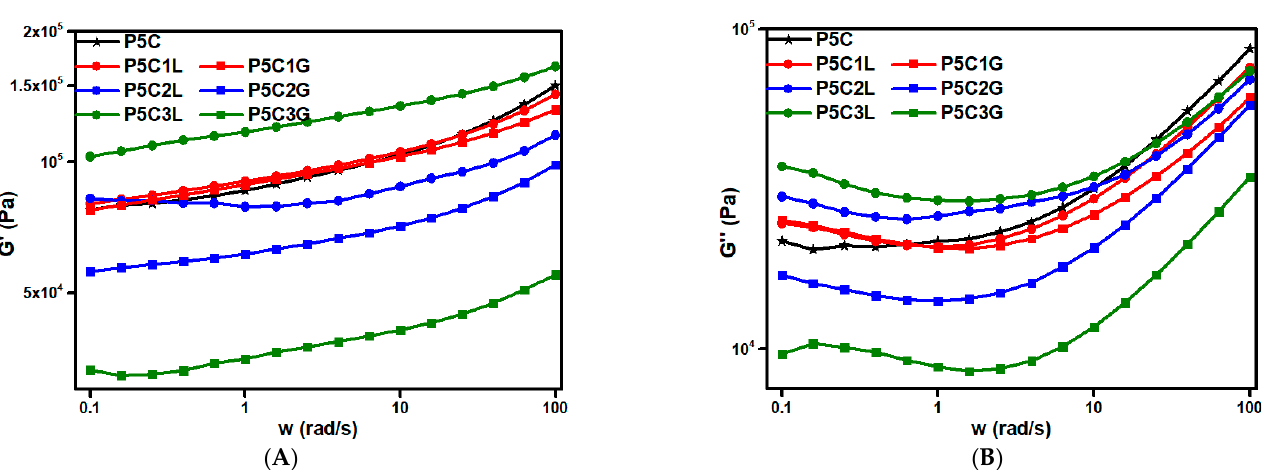
Figure 6. SEM micrographs of 3D printed samples of PLA/MWCNT with ( A ) 1, ( B ) 2, and ( C ) 3 percent of lignin, ( D ) 1 ( E ) 2 ( F ) 3 percent of PEG.